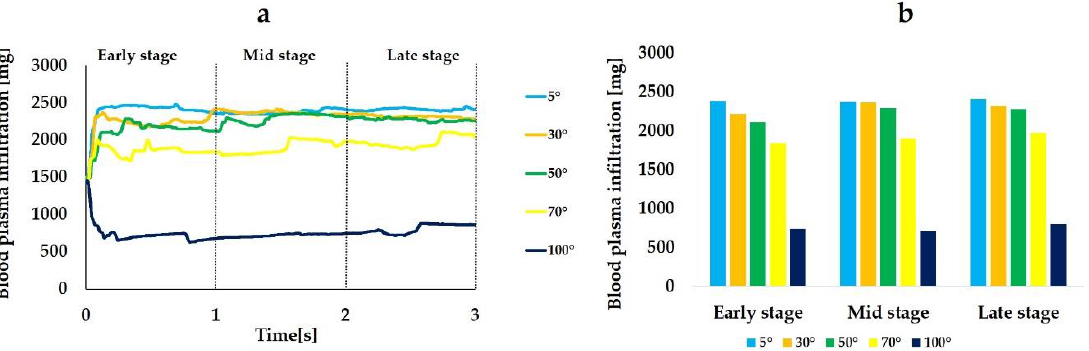
Figure 6. Blood plasma infiltration (mg) varying with different levels of hydrophilicity or hydrophobicity of the implant surfaces. Line plot graphs ( a ) and integral-based histograms in the early, mid, and late stages ( b ).